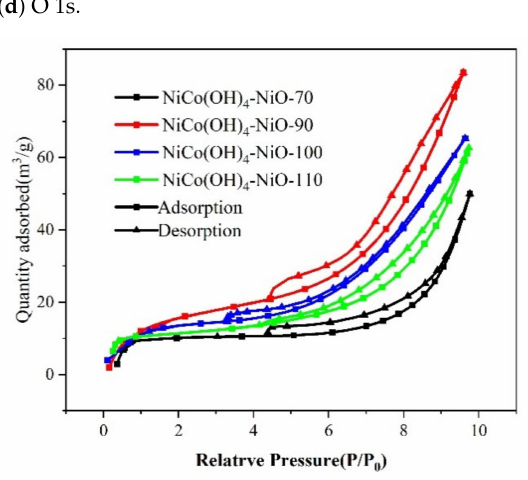
Figure 3. XPS spectra of NiCo (OH) 4 -NiO nanocomposite: ( a ) survey spectrum, ( b ) Ni 2p, ( c ) Co 2p, ( d ) O 1s.